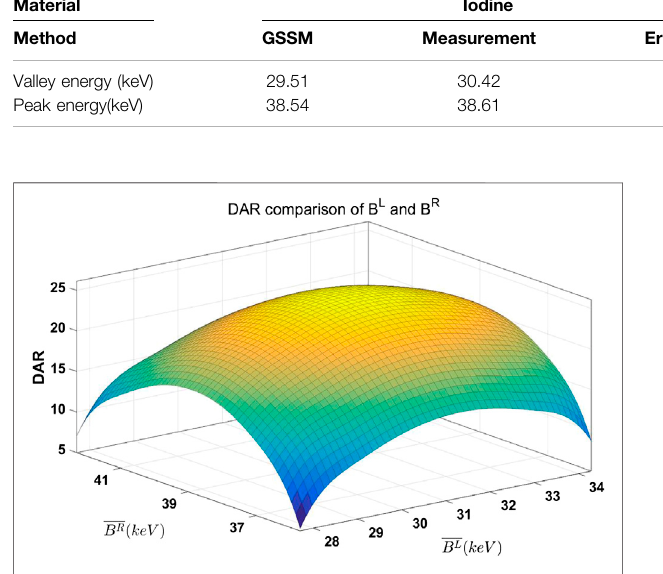
TABLE 1 | The energy positions of the K-edge extreme points of iodine and gadolinium. Material